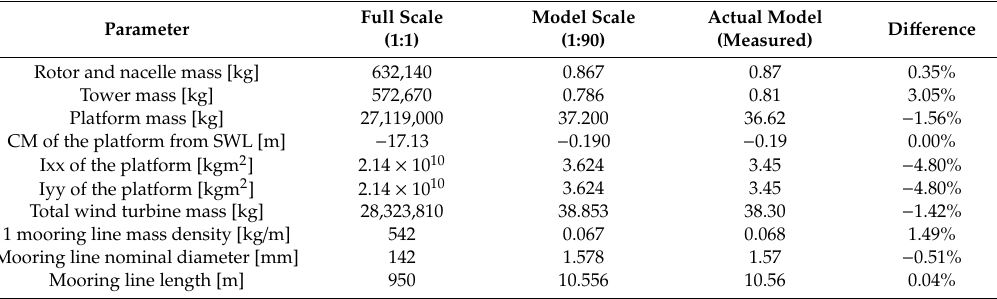
Table 3. Difference between the actual and target model. Table 3. Di ff erence between the actual and target